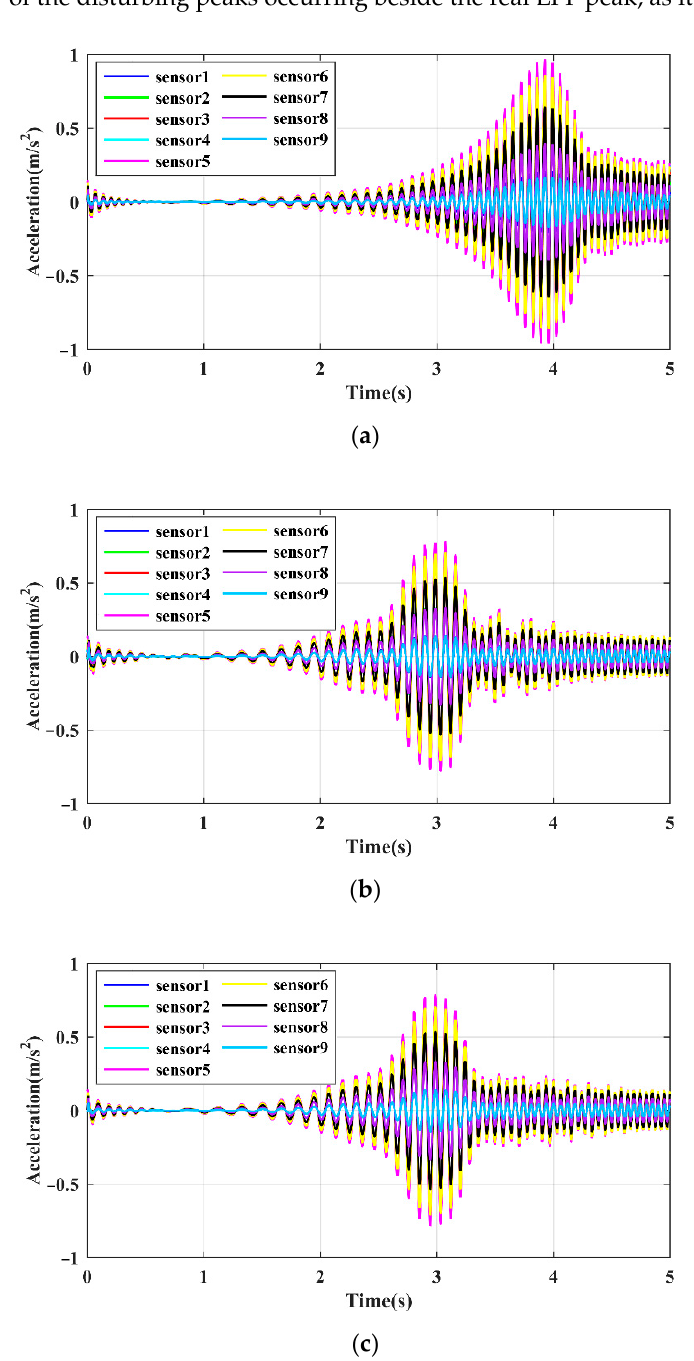
Figure 10. Time domain responses measured by different sensors: ( a ) beam 1; ( b ) beam 2; ( c ) beam 3.